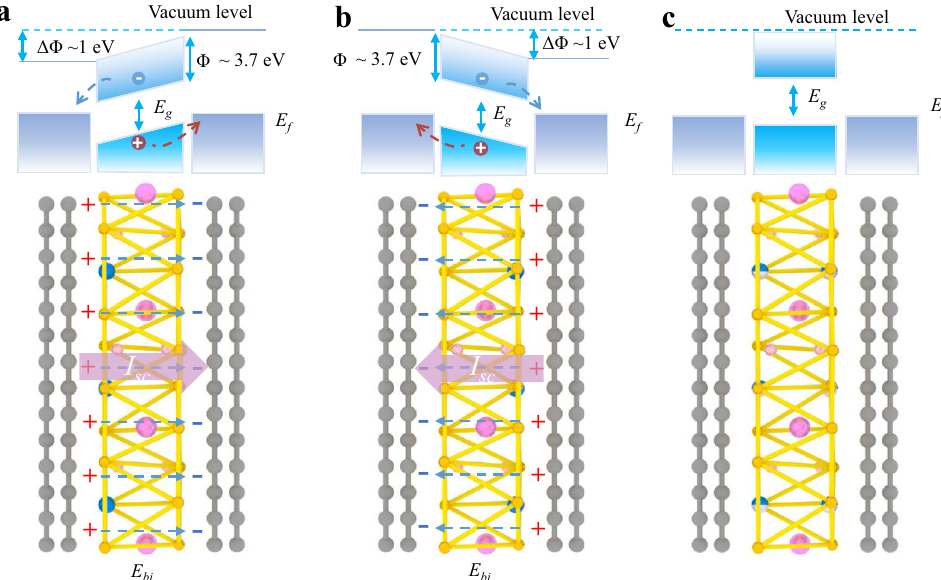
Fig. 4 Energy band alignments in the 2D CIPS device. a , b The band diagram for the graphene/CIPS/graphene heterostructure at the upward and downward electric polarization state of ferroelectric CIPS. The top and bottom graphene electrodes are represented with slabs of atoms in gray on the left and right sides of CIPS. In the heterostructure, the polarization charges are marked with “ + ” and “ − ” symbols, and the built-in electric fi eld are indicated by the dashed lined arrows. The cartoon on the top depicts the corresponding energy shift of the conduction band and valence band. c The band diagram of the device with the CIPS at the paraelectric